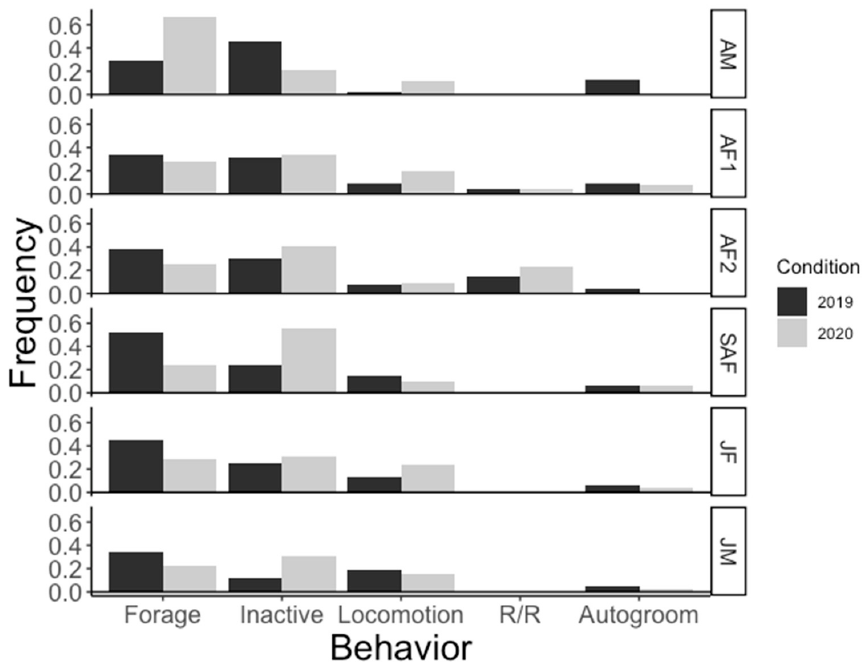
Figure 2. Proportion of time spent in each behavior for each individual gorilla. “Pluck” and “Social Play” were omitted as they occurred too rarely to visualize on the graph.